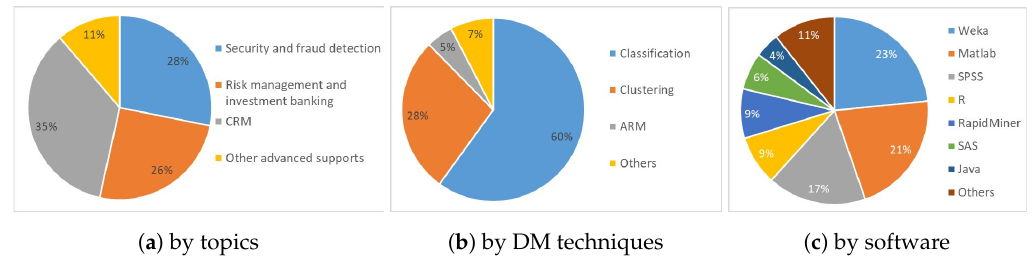
Figure 2. Key facts on DM applications in banking since